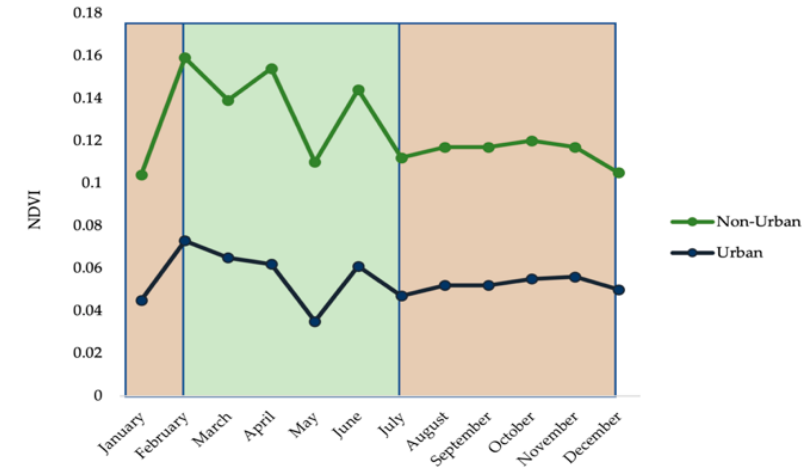
Figure 5. Calculating the median Sentinel-2 per pixel value across multiple months has several advantages, such as (1) significantly diminishing spectral e ff ects from shadows, clouds and snow across SoCAB and (2) potentially enabling observation of vegetation phenological traits between leaf-on and leaf-o ff periods in urban and non-urban regions of SoCAB. We chose the distinct periods to be February-June for rising urban and non-urban NDVI that indicate leaves coming on, and July-January for decreasing NDVI as leaves senesce and eventually die.